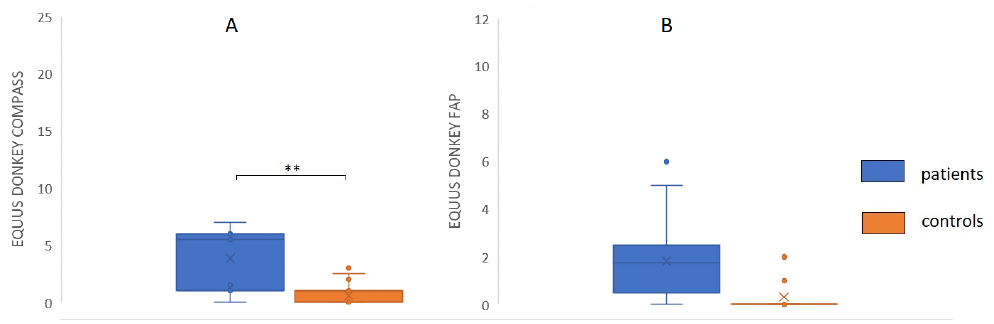
Figure 4. EQUUS-DONKEY-FAP patients versus controls. (A ) Facial pain ( n = 18 patients versus n = 39 controls), ( B ) Orthopaedic pain ( n = 25 patients versus n = 68 controls); ( C ) Colic pain ( n = 12 patients versus n = 28 controls), ( D ) Postoperative pain ( n = 24 patients versus n = 50 controls). Lines in boxes show median scores; x — mean value; boxes show 25th – 75th percentiles; error bars show 5th – 95th percentiles. *** — p < 0.001.